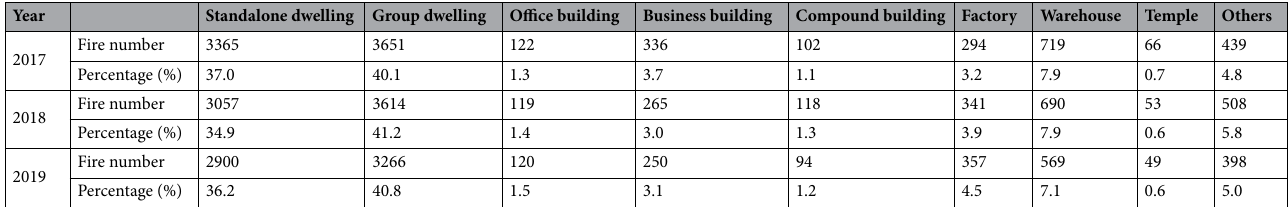
Table 1. Fire case statistics in the last 3 years in Taiwan.